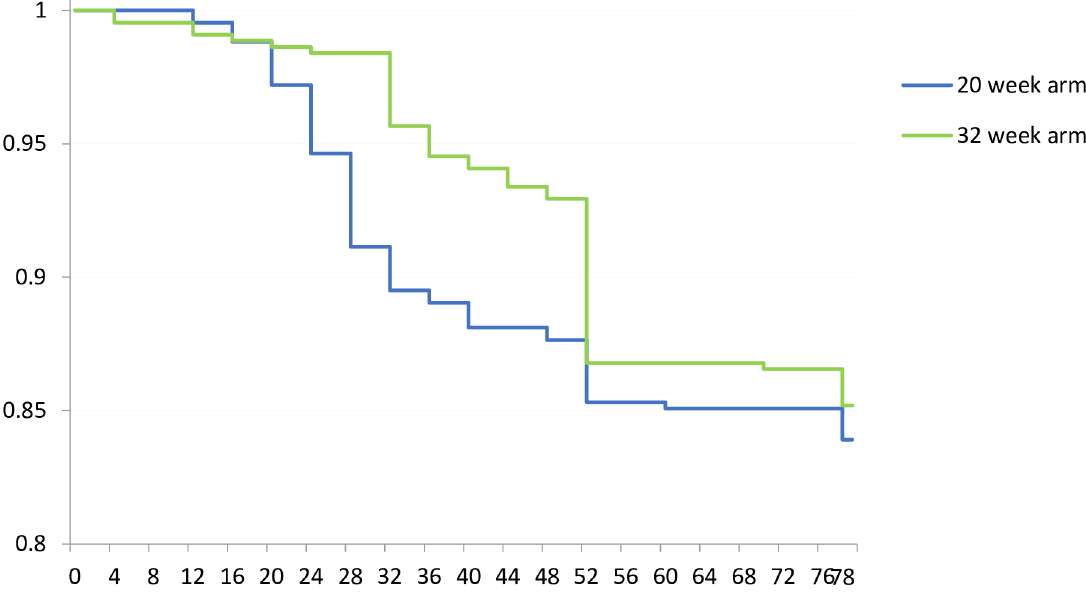
Fig 4. Time until first event requiring additional prednisolone, i.e. a leprosy reaction and/or new NFI and/or deteriorating NFI (n = 868).